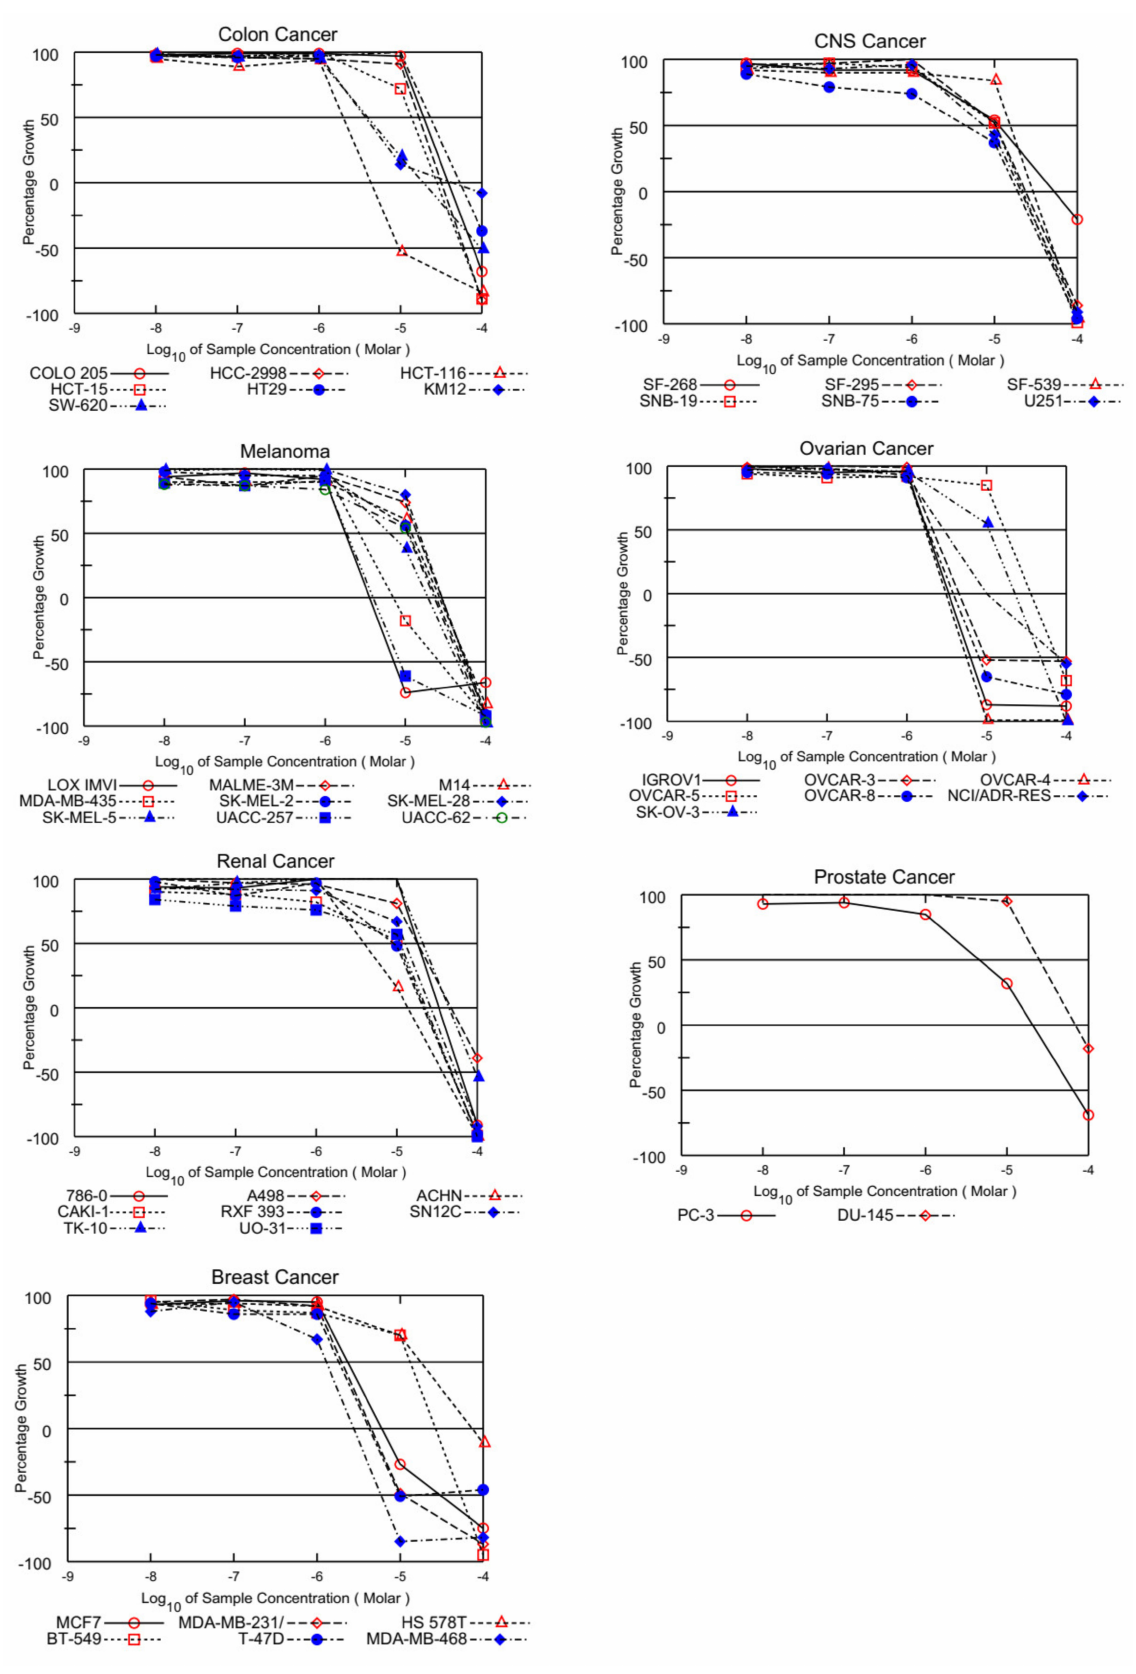
Figure 4. Graphical presentation of growth inhibition of ABQ-3 at five-dose